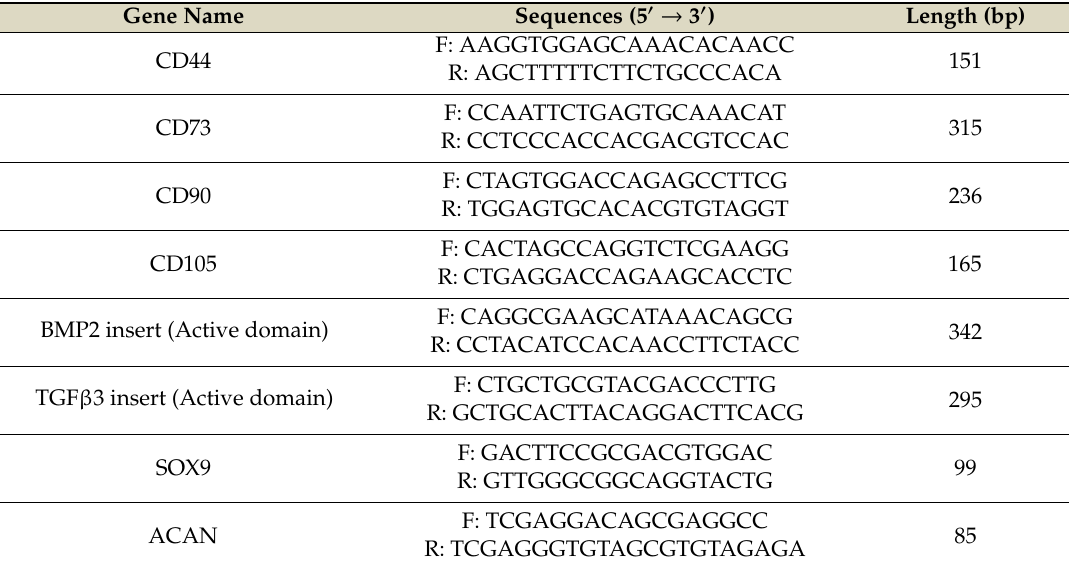
Table 2. Primer sequences for PCR